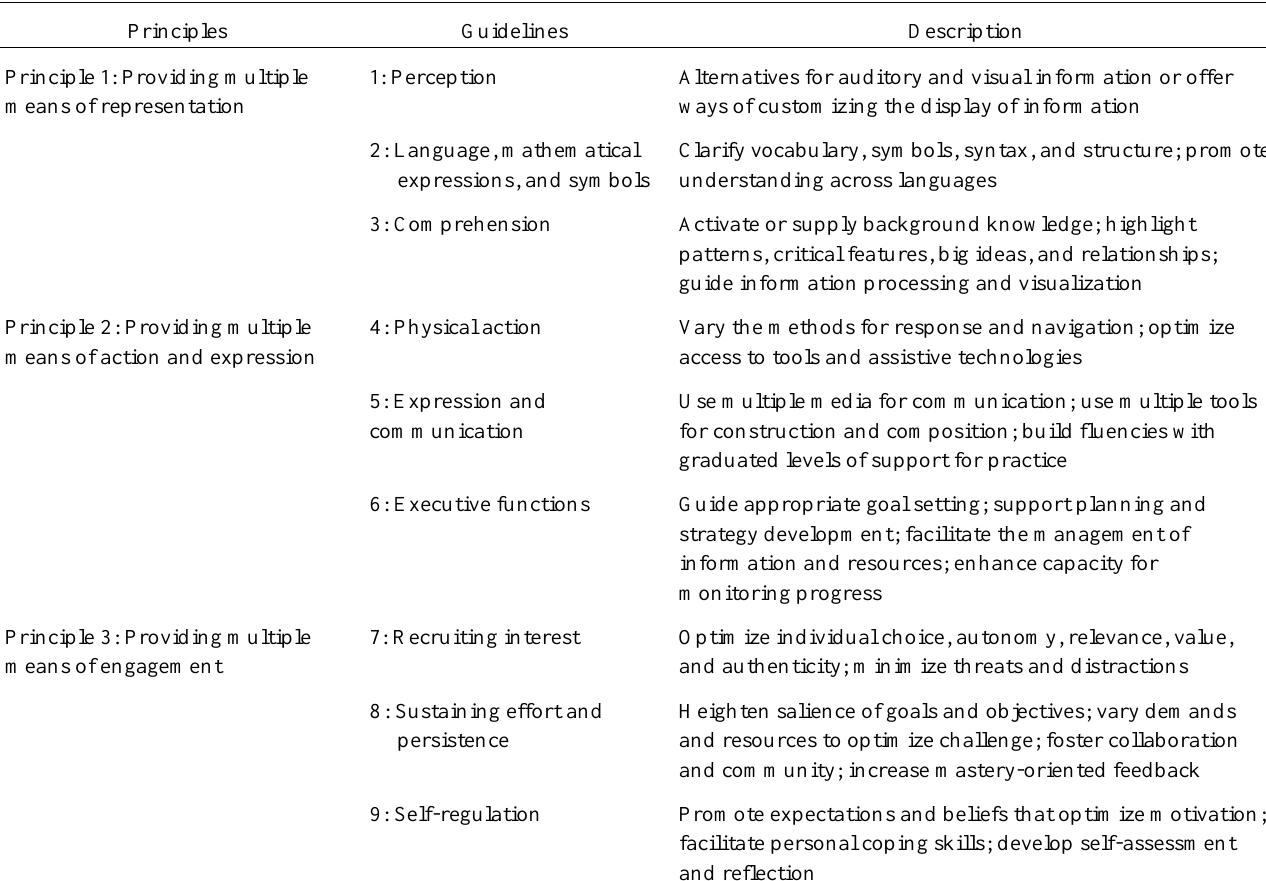
A Description of UDL Principles and